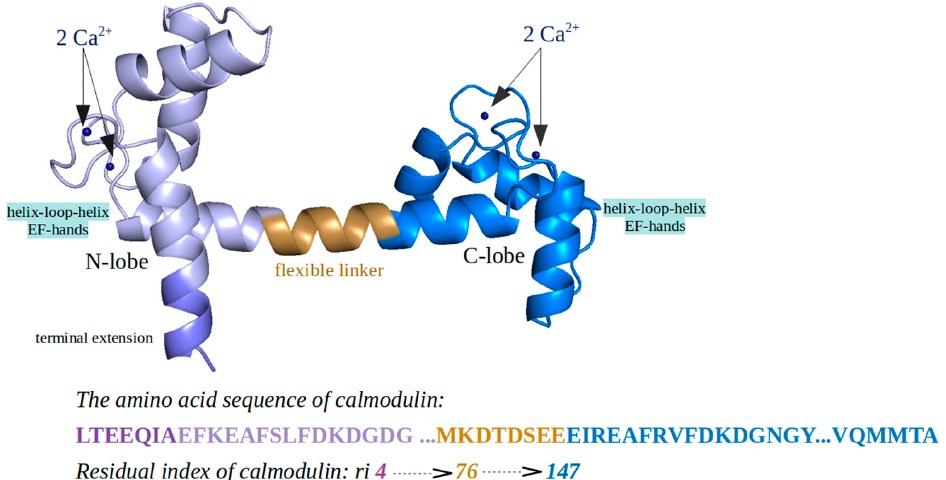
Figure 1. Three-dimensional (3D) structure of calmodulin Figure 1. Three ‐ dimensional (3D) structure of calmodulin protein.